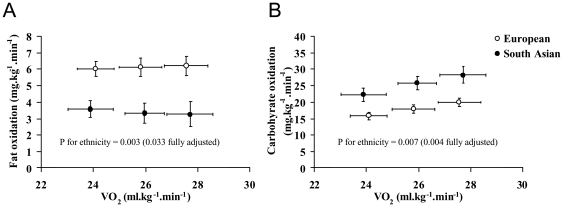
Fat oxidation (A) and carbohydrate oxidation (B) during incremental submaximal exercise.Intensity expressed in terms of absolute oxygen uptake (i.e. ml.kg−1.min−1). P values shown are for the main-effect difference between European and South Asian groups, either unadjusted, or adjusted for age, BMI and fat mass.